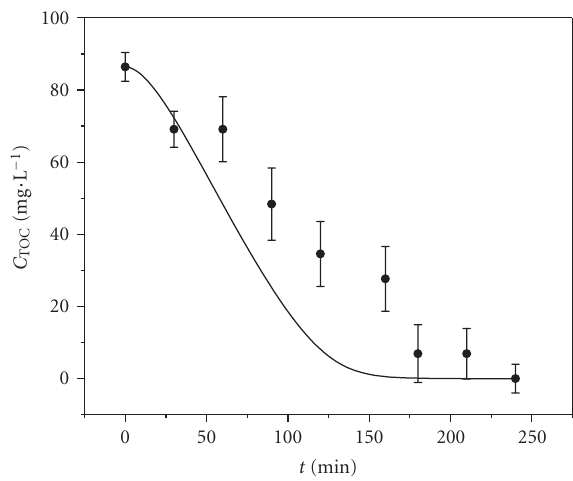
Figure 3: TOC concentrations, C TOC , in mg · L − 1 , obtained by calculation from COD measurements, as a function of time t , in minutes, for a kinetic run, starting from a DCP concentration of 84ppm, expressed as carbon, during which measurements of the decrease of organic substances, either substrate or intermediates, versus time t , expressed in minutes, was measured by the COD method. Absorbed radiation power per unit membrane length was 1.50W · cm − 1 and overall reacting volume 4.0 L. In the laboratory- scale photoreactor (see Experimental), standard photocatalytic membranes, immobilising 30 wt.% of P-15 titanium dioxide, were employed. The curve reported in this figure is that simulated by the four-parameter kinetic model, used in the present work, at the same initial concentration of DCP, and at the same radiating power (see Table 1).